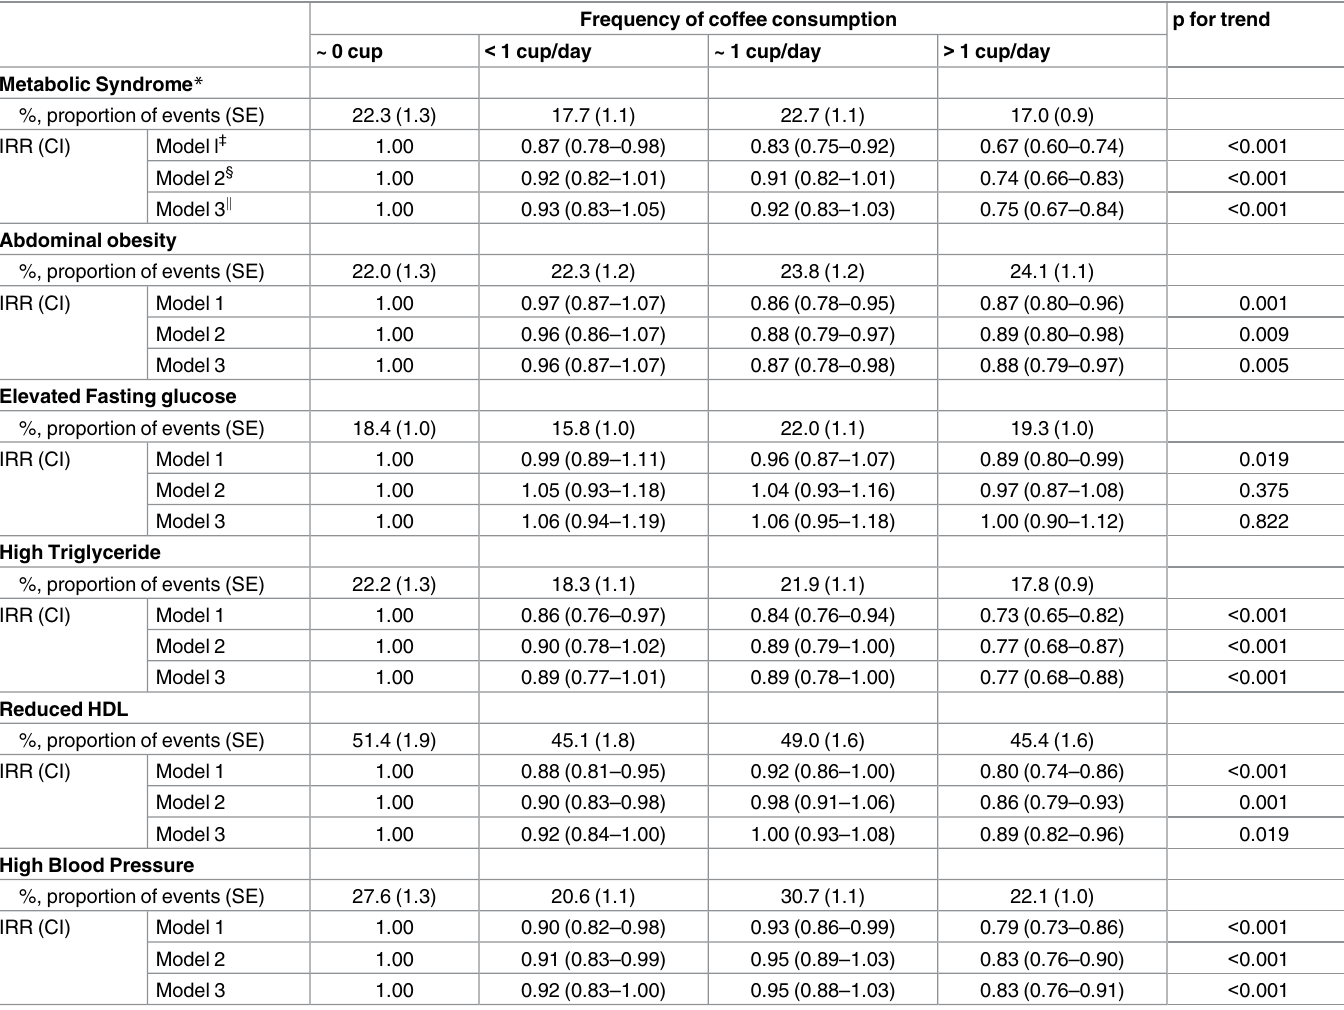
Table 2. The prevalence of metabolic syndrome by the frequency of coffee consumption. Frequency of coffee consumption p for